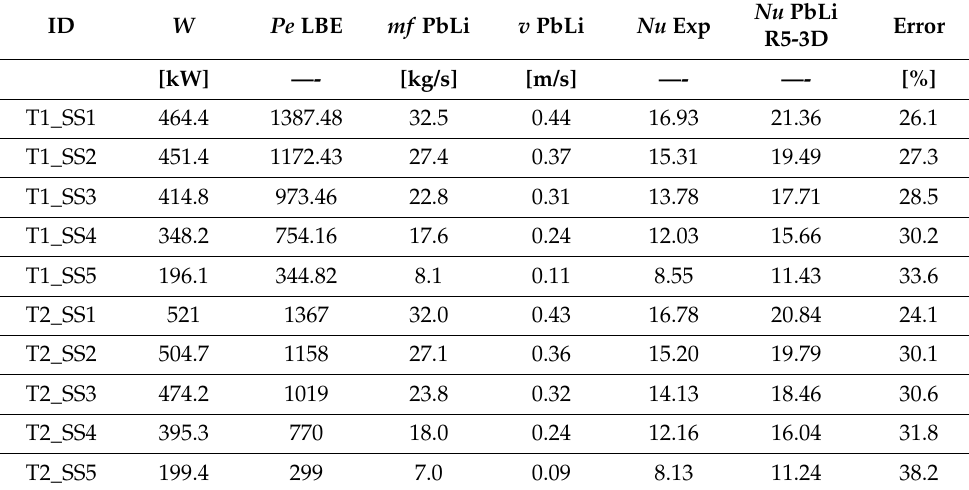
Table 4. CIRCE-HERO EF-T1 and EF-T2: equivalence between LBE and PbLi using method #1, preserving the Peclet number and Nusselt number: experimental vs. RELAP5-3D